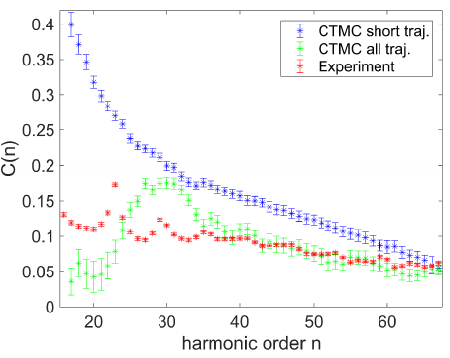
Figure 10. The displacement gate contrasts C ( n ) extracted from fitting Equation (14) to the experimental data (red [18]), the CTMC TIPIS model (Tunnel ionisation in Parabolic coordinates with Induced dipole and Stark Shift) with only short trajectories (blue) and the CTMC TIPIS model considering all trajectories (green). The error bars show the 95% confidence interval of the Equation (14)